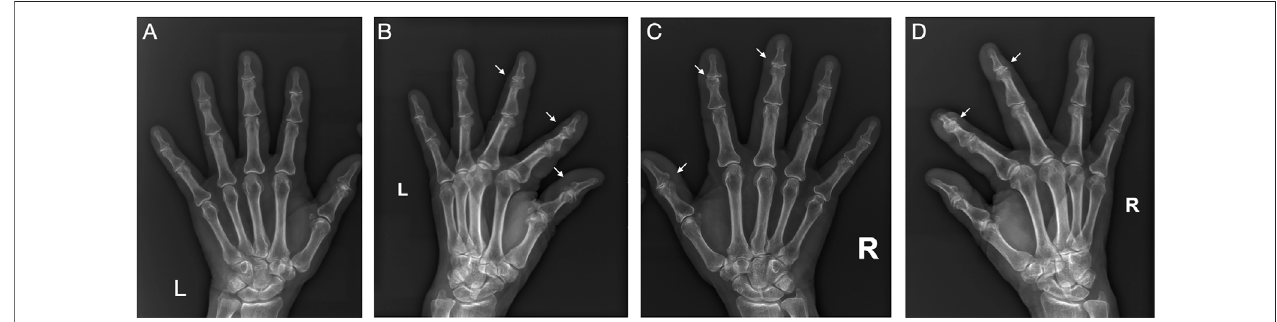
FIGURE 1 | Typical X-ray fi lms of OA in hand. This is the X-ray fi lms of both hands of a 71-year-old obese woman (BMI 28.0). Signi fi cant manifestations of OA (narrowingofjointspace,osteophyteformation,andsubchondralbonesclerosis)canbeseeninthesenon-weight-bearingjoints. (A) Frontalviewoflefthand; (B) Lateral view of left hand; (C) Frontal view of right hand; (D) Lateral view of right